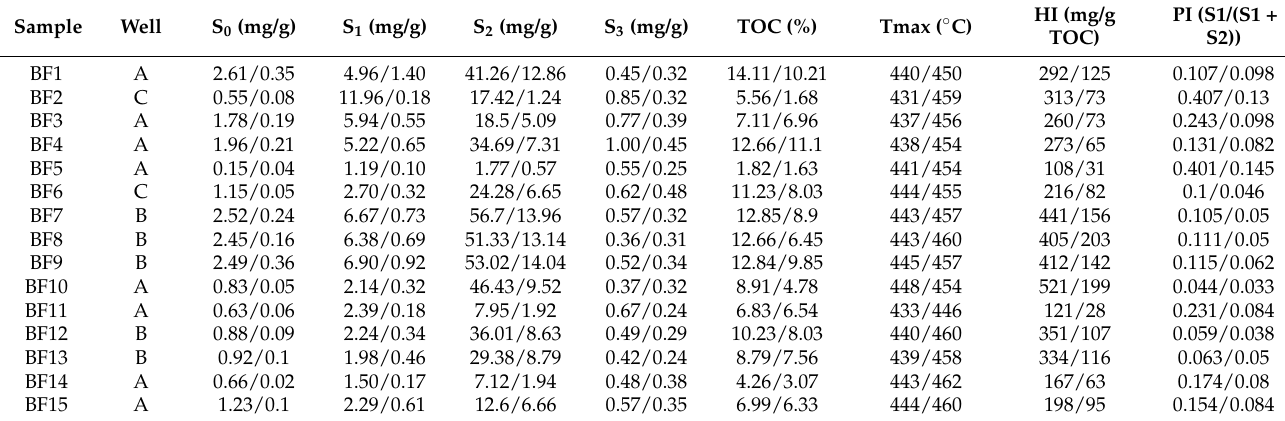
Table 1. Rock-Eval pyrolysis parameters of the non-extracted oil shale samples before / after the experiment. Sample